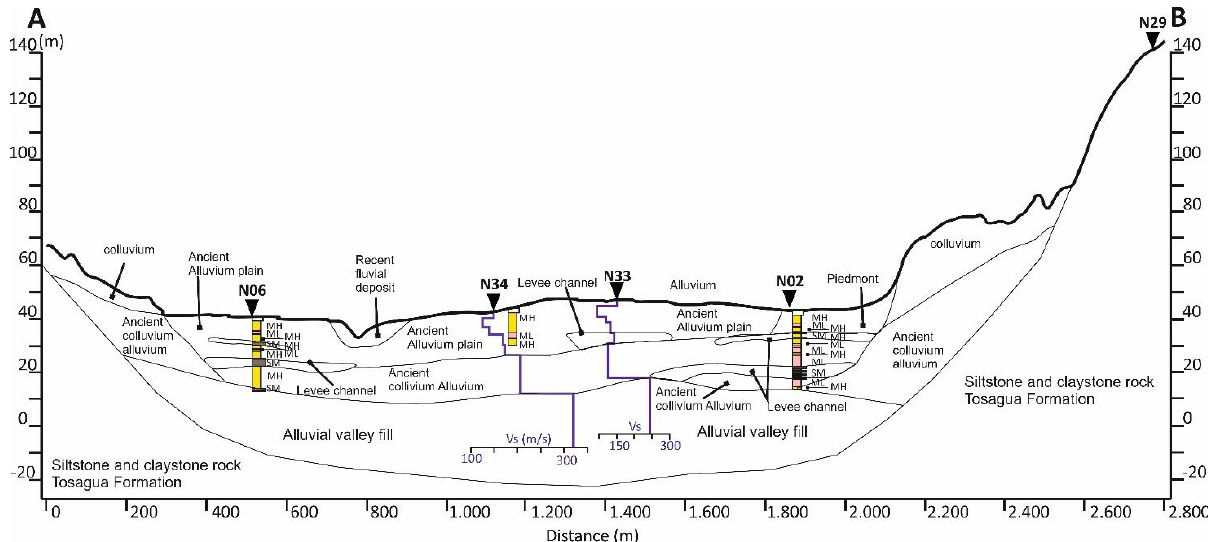
Figure 4. Geological and soil profile in the urban area of the city of Portoviejo.